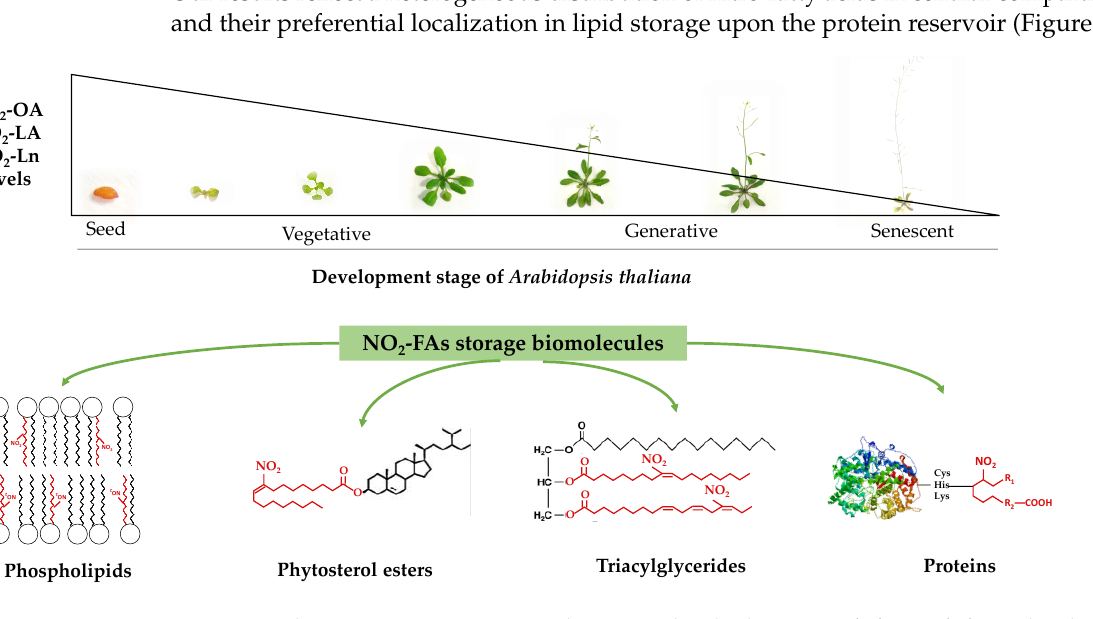
Figure 7. The NO 2 -OA, NO 2 -LA, and NO 2 -Ln levels during Arabidopsis thaliana development (panel ( A) ) and the identification of phospholipids, phytosterol esters, triacylglycerides, and proteins as NO 2 -FAs storage biomolecules in Arabidopsis (panel ( B )).